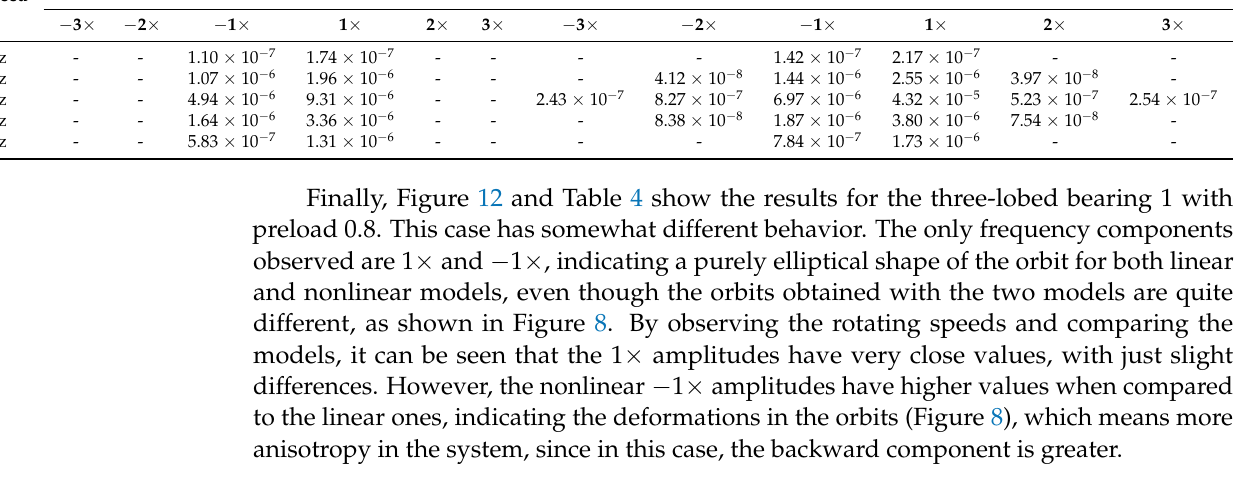
Figure 11. DFT full spectrum of simulated results in three-lobed bearing 1 (preload 0.25): ( a ) linear, ( b ) nonlinear. Table 3. Magnitudes of the most relevant peaks of Figure 11—three-lobed bearing (preload 0.25). Amplitudes Rot. Speed